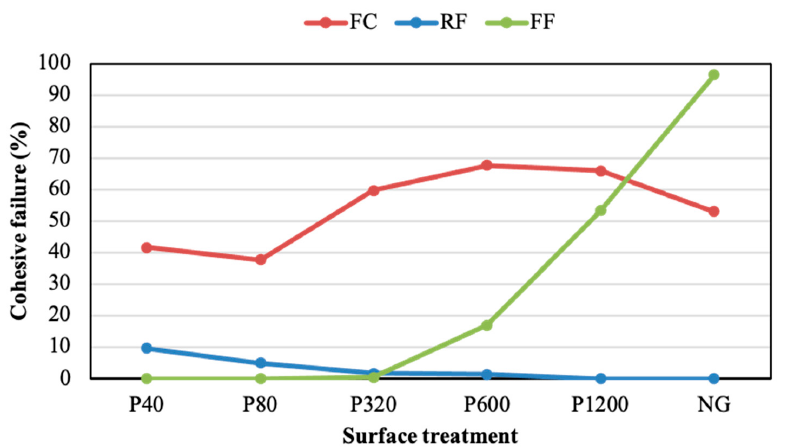
Figure 6. Cohesive failure percentage of adhesive joints under different surface treatments without adhesion promoter.